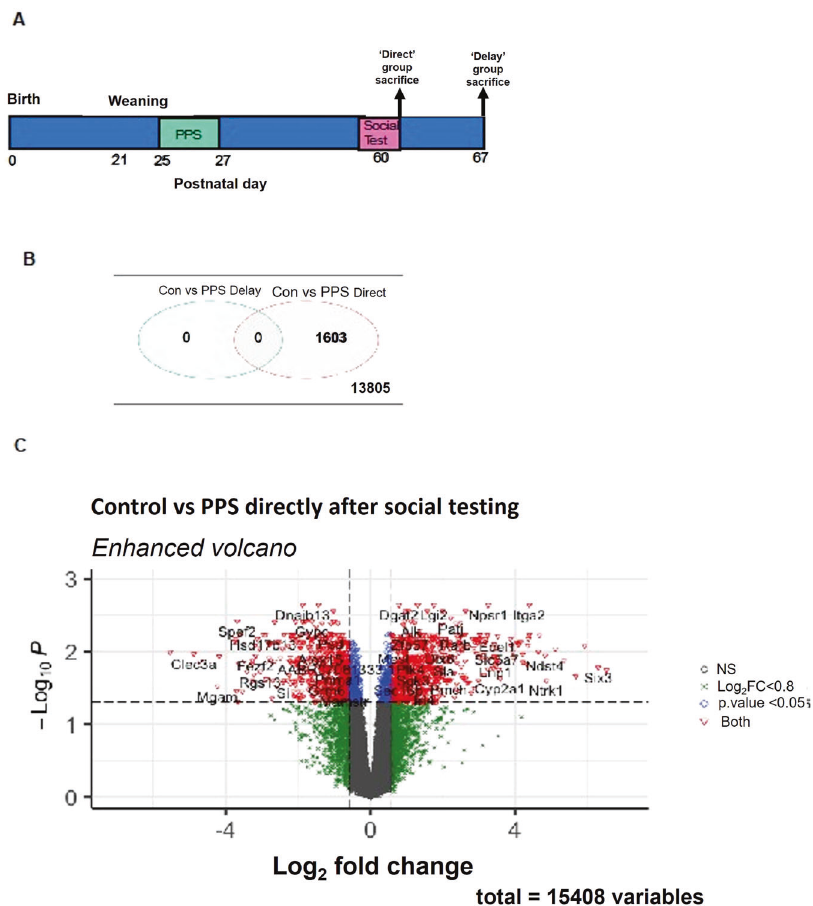
Fig. 1 Experimental timeline and differentially expressed genes. A Timeline of the experiment. B Venn Diagram displaying DEGs between CON vs PPS animals directly following a social test (Con vs PPS Direct) and in a baseline state, 1 week after the social test (Con vs PPS Delay) following limma analysis. No DEGs were seen in the Delay (baseline) group. 1603 DEGs were observed in the Direct group, whilst 13805 genes did not differ in expression. C Enhanced Volcano Plot demonstrating DEGs in the Direct group (Con vs PPS). All genes above the dotted line were differentially expressed, green points represent log2FoldChange, blue represent genes <0.05 and red points represent those genes that meet both criteria. Genes were considered differentially expressed if P < 0.05 following Bonferroni correction. DEGs differentially expressed genes, CON control, PPS prepubertal